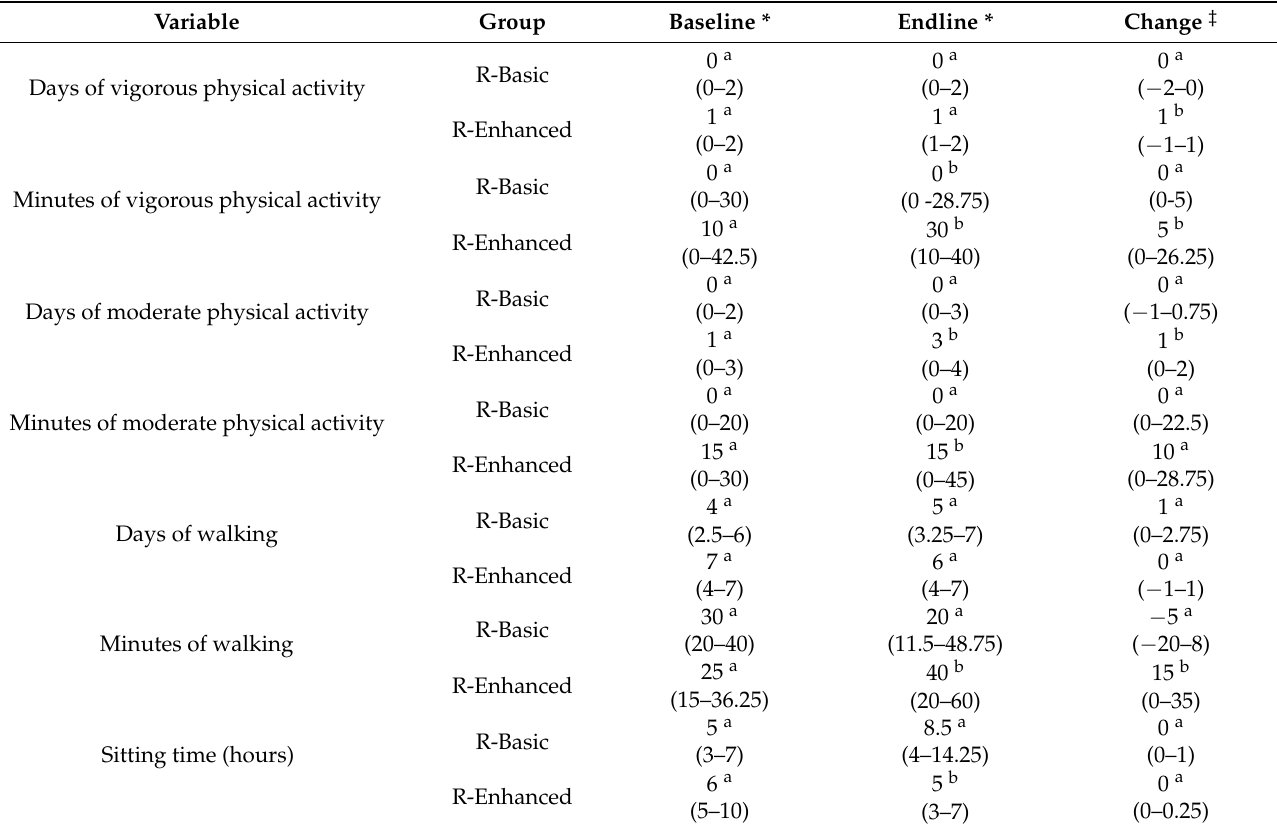
Table 3. Physical activity levels in Rashakaty Basic ( n = 54) and Rashakaty Enhanced ( n = 111)